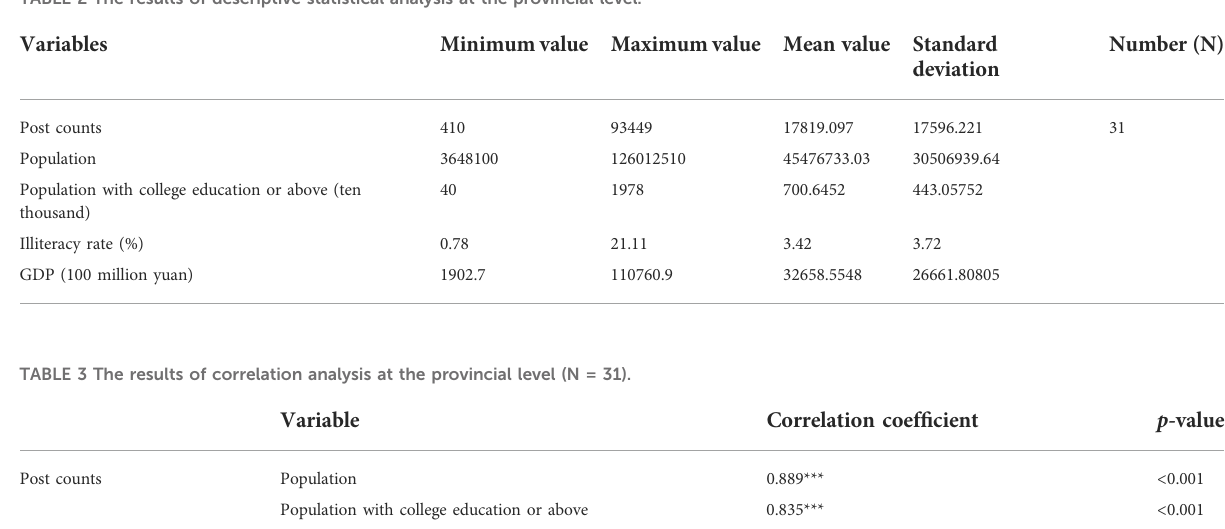
TABLE 2 The results of descriptive statistical analysis at the provincial level.